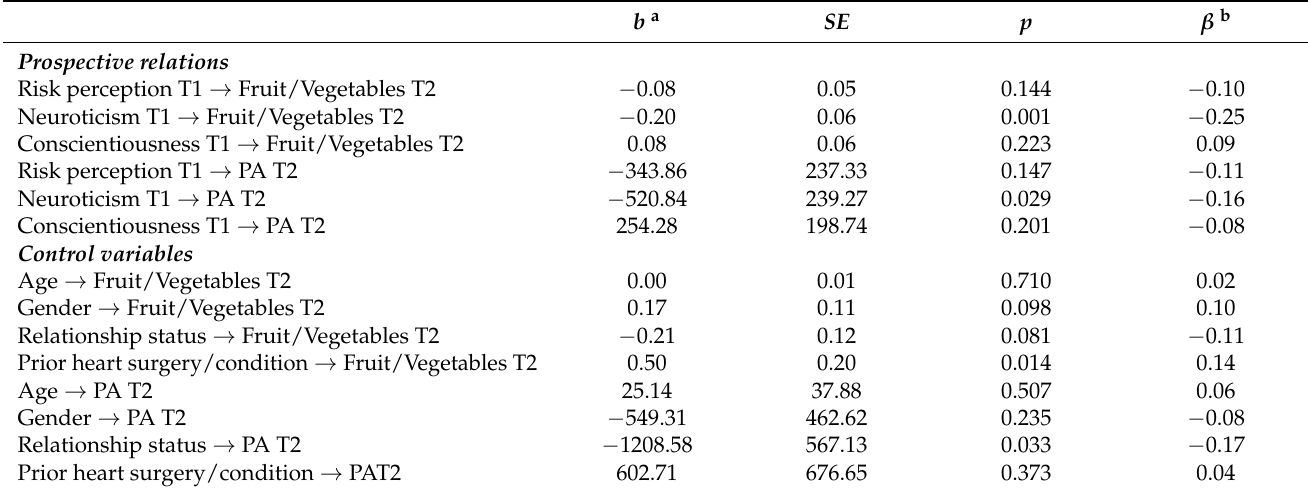
Table 4. Path model with health behaviors at T2 as outcome